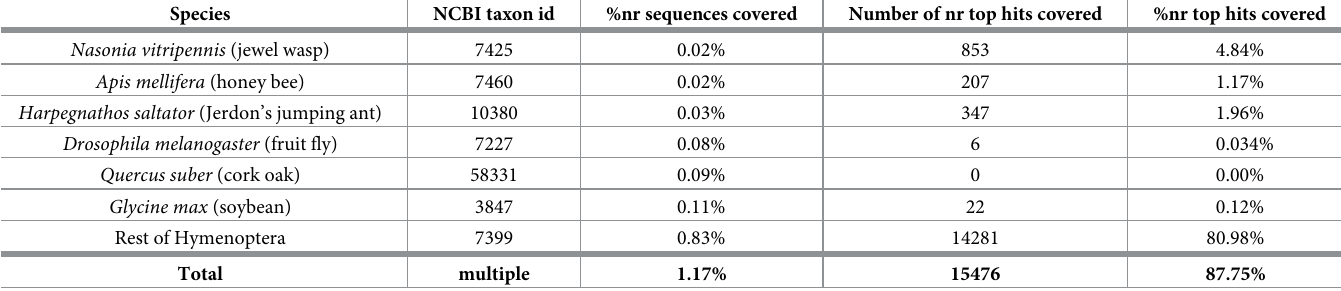
Table 3. Potential for taxon-guided searches enabled by iBLAST. Comparison of merged BLAST results from multiple individual BLAST searches with a separate BLAST search conducted against a completed nr database shows that biologically relevant taxa can be added incrementally to obtain similar results to nr by searching against a much smaller database